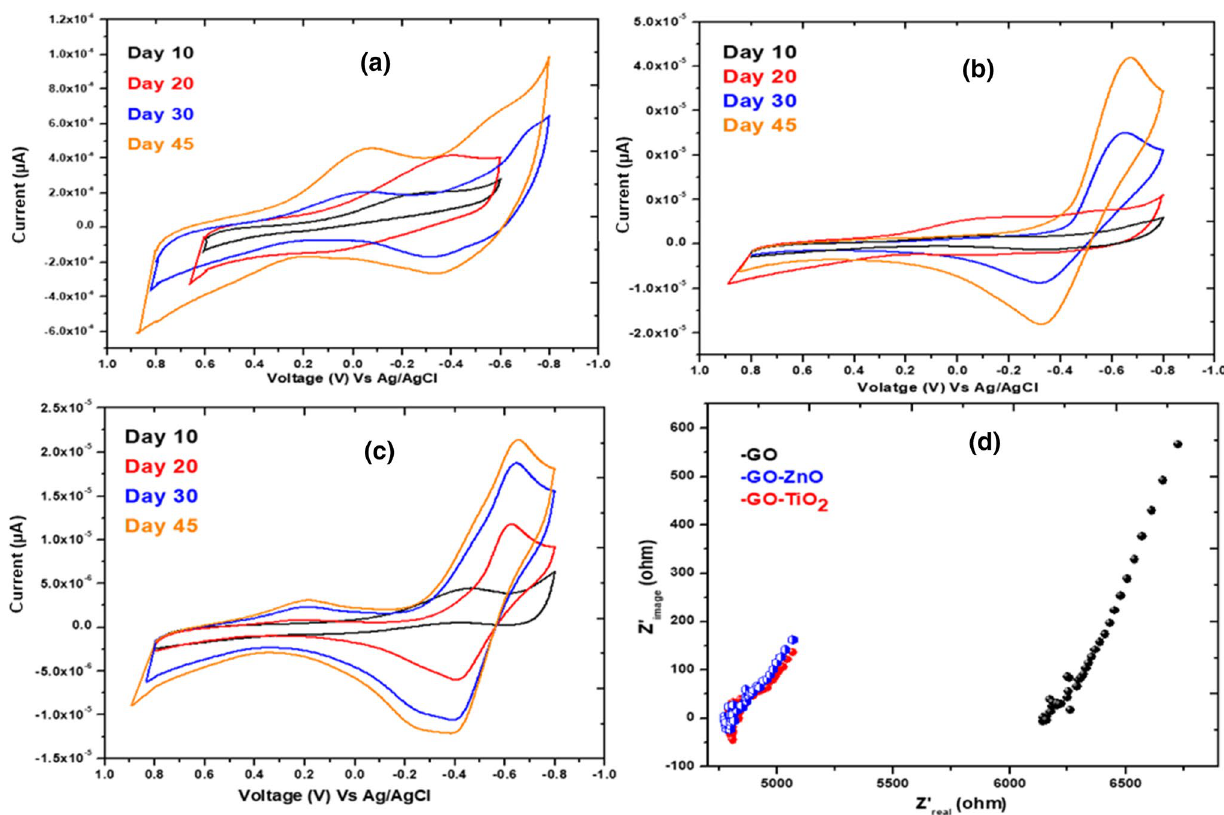
Fig. 6 CV curves of a GO anode b GO-ZnO composite anode c GO-TiO